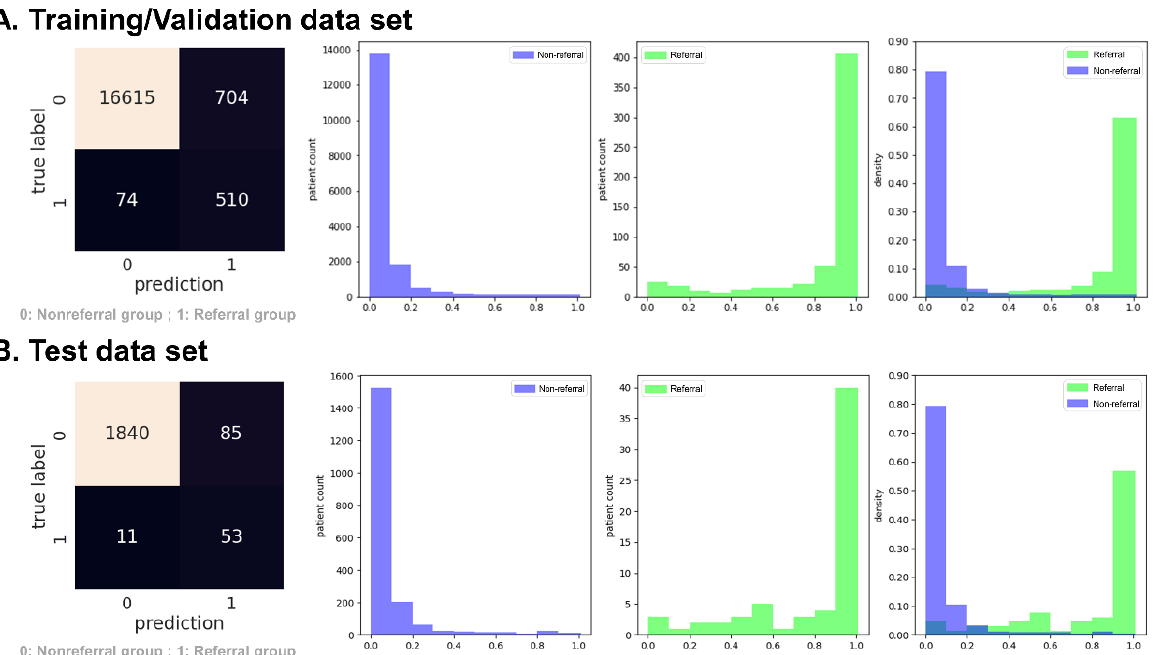
Figure 3. Confusion matrix and predictive probabilities histogram of the XGBoost model in experiment 1 (persistent eGFR < 30 mL/min/1.73 m 2 ). The green in the histogram represents the referral group, and the medium slate blue represents the non-referral group. Figure 4 demonstrates the SHAP summary plot of the top 15 features for the XGBoost model in experiment 1. The higher the SHAP value of a feature, the higher the probability of rapidly progressive kidney disease. A dot denotes each feature value for the model of each patient. The dots are colored according to the values of the features for the respective patient and accumulate to describe the density. Blue represents the lower feature values, and red represents the higher feature values.